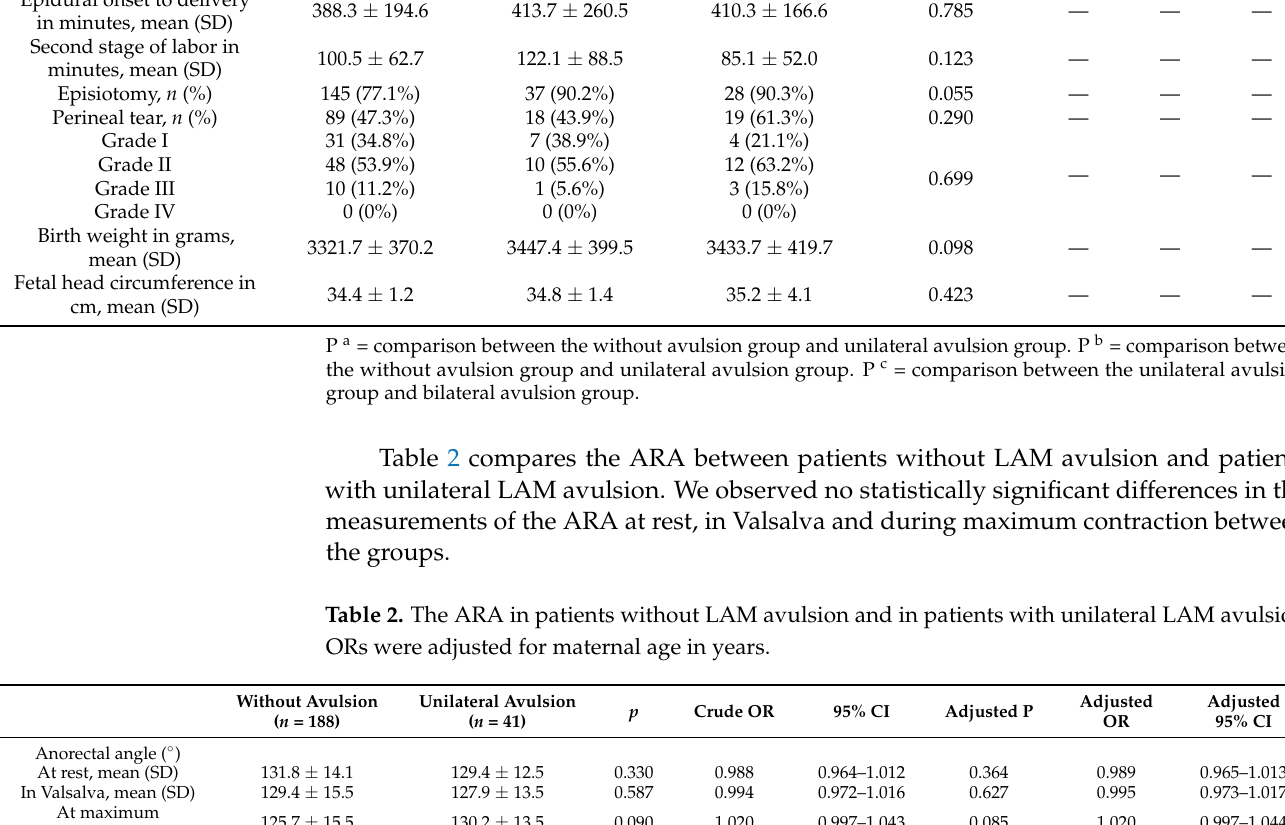
Table 1. General characteristics of the patients included according to the presence or absence of LAM avulsion. Without Avulsion ( n = 188)